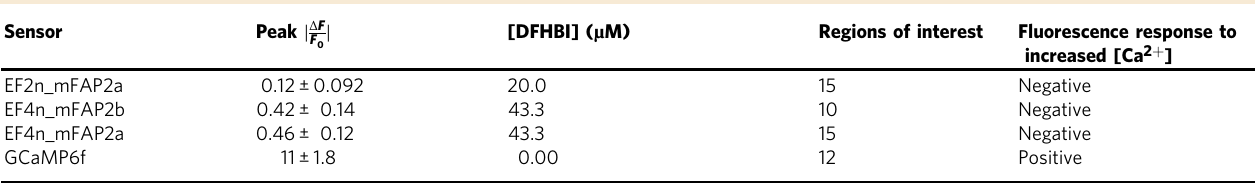
Table 2 Fluorescence response to acetylcholine stimulation of HEK293 cells expressing cytosolic Ca 2 + -responsive mFAPs or